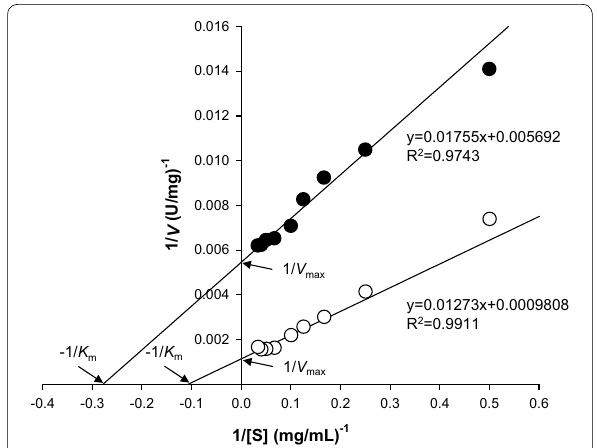
Fig. 4 Lineweaver–Burk plots for determining the kinetic parameters of rAgaB‑4 acting on low‑melting point agarose (open circle) and high‑melting point agarose (closed circle). V velocity; S substrate concentration. All data are mean values from triplicate experiments